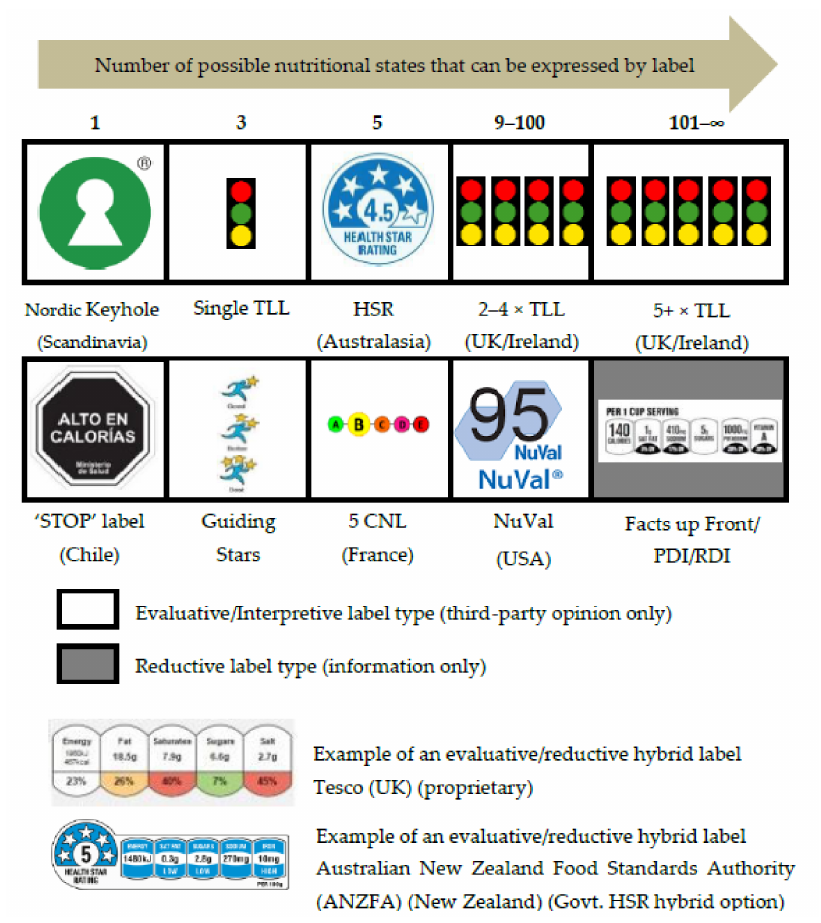
Figure 1. Major FoP nutritional labels types currently deployed around the World.